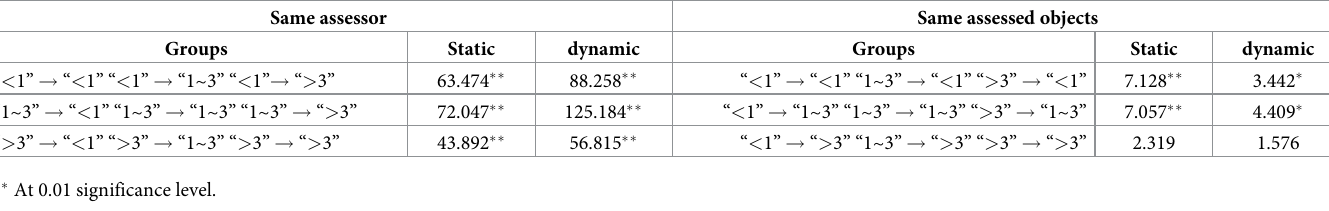
Table 9. Mutual-assessment difference among different driving year